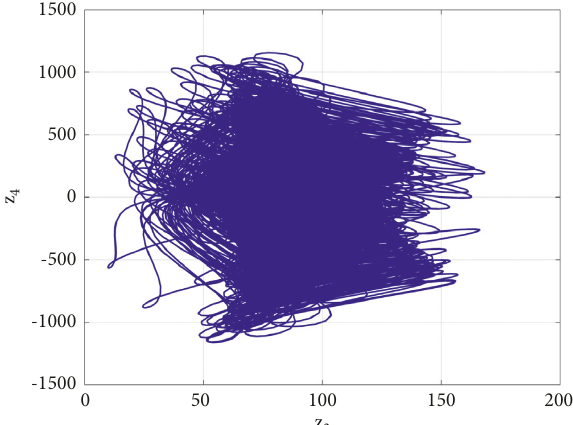
23: A chaotic attractor of the model (1) for d � 180 and ( a,b, c ) � ( 25 , 8 , 90 )